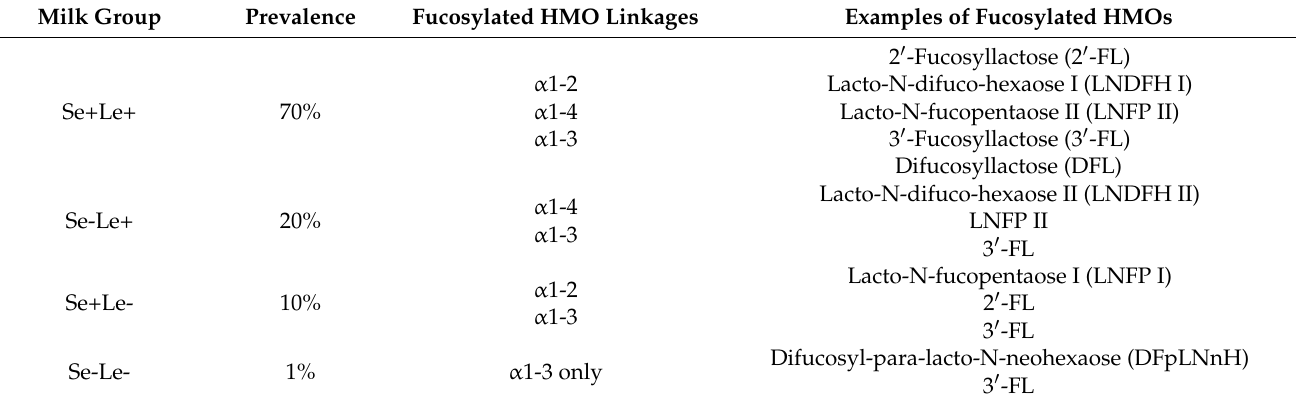
Table 3. The four different milk groups based on genotypes of Le and Se genes, with prevalence, type of linkages in HMOs, and HMO examples. Prevalence is dependent on data from Thurl et al. and refers to the European population [201]. Milk Group Prevalence Fucosylated HMO Linkages Examples of Fucosylated